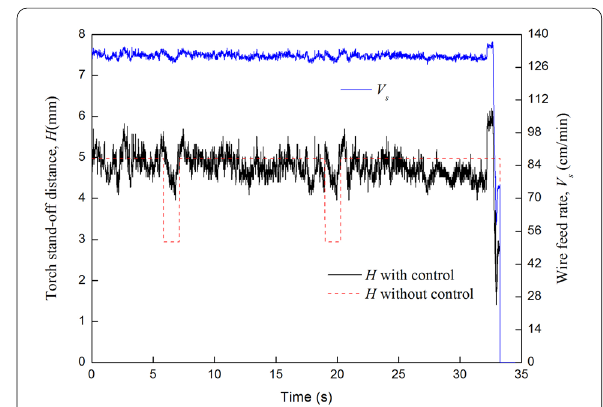
Figure 18 Voltage and wire feed rate for second deposition